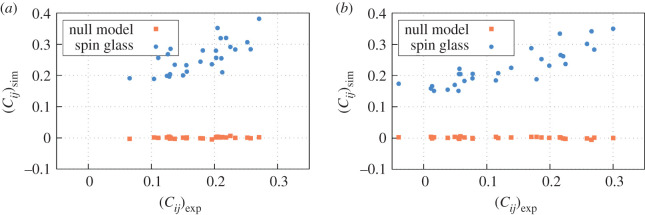
Experimental correlation between the nodes i and j (Cij)exp in comparison to virtual correlations obtained from MC simulations (Cij)sim, for (a) regime A and (b) regime B.